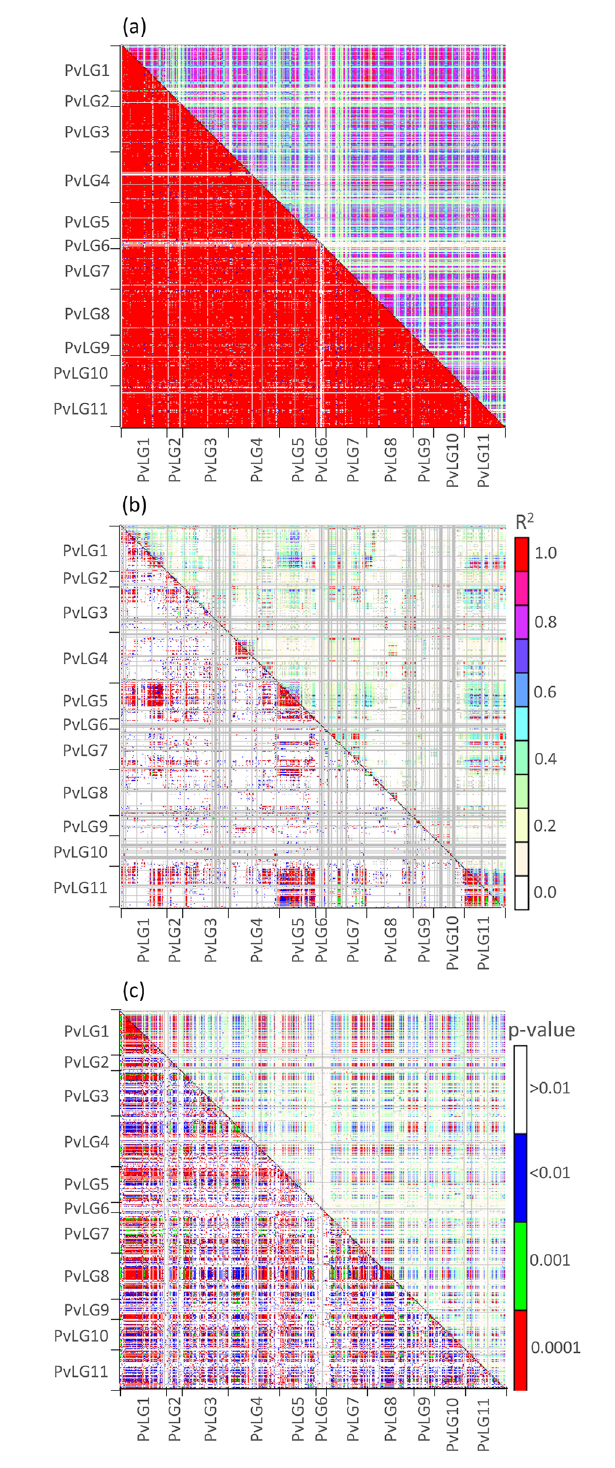
Fig 4. Genome-wide linkage disequilibrium as measured by r 2 (upper triangles) and its p-value (lower triangles) (a) across genepools, (b) within the Andean genepool, and (c) within the Mesoamerican genepool. Linkage groups are shown in the